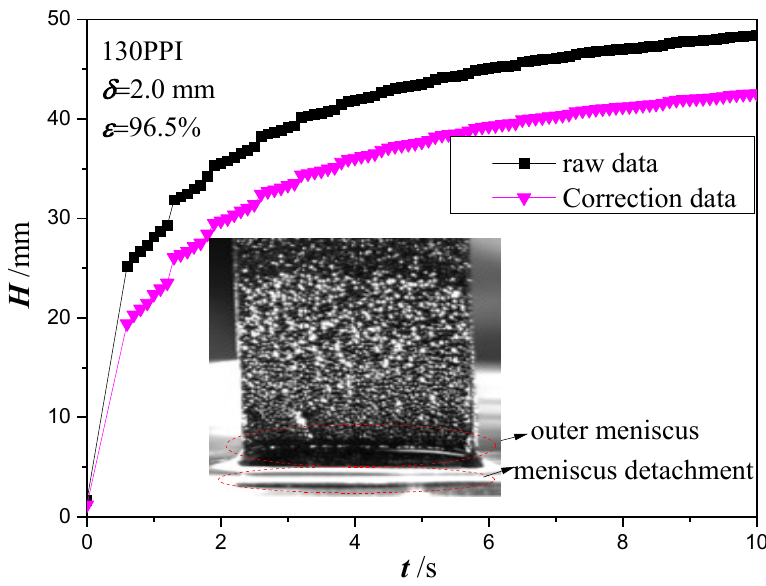
Figure 7. Wicking height at the initial stage 0~10 s. Based on the above-represented approaches, the correction wicking heights versus time for four copper foams with thickness of 2 mm and different PPI are shown in Figure 8. The liquid ascends rapidly through the copper foam during the first 50 s when the gravity and viscous force restraining liquid rise is much smaller than the capillary force lifting it up. The rise velocity then decreases and the lifting height gradually reaches stability. The wicking height increases as the increase of PPI and the best wicking height is obtained for copper foam with a PPI of 130. With the increase of PPI, a smaller void will be obtained which results in a larger capillary pressure and an associated greater flow resistance. In this case, it can be found that the effect of PPI on the capillary pressure is more significant than that of flow resistance.